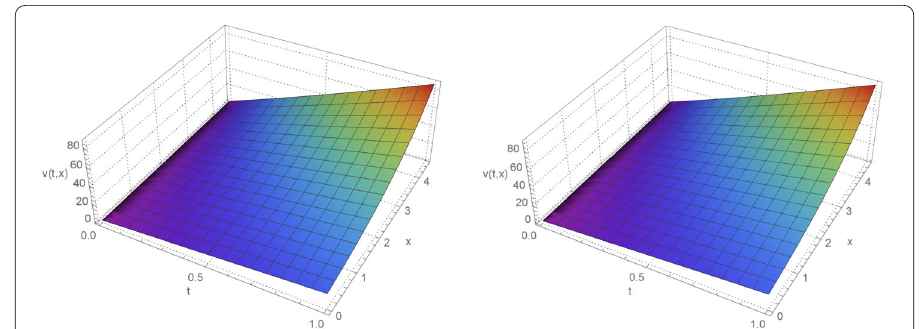
Figure 11 RPSM vs. q-HAM for Case II for V (2) ( t , x ) with β = 0.1, γ = 0.1 and α = 0.55